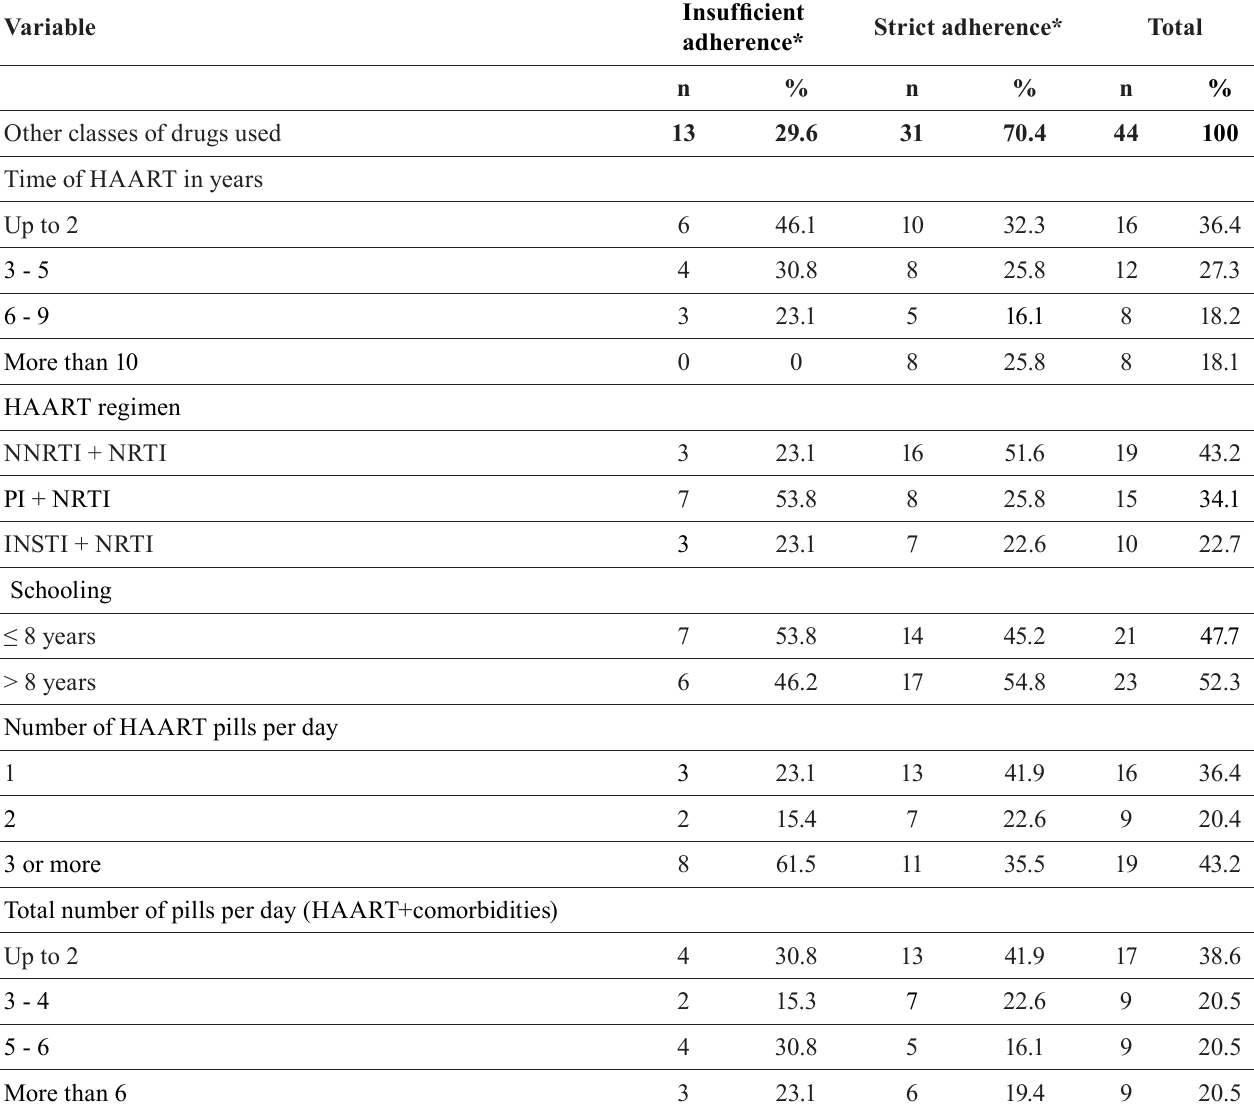
TABLE VI - Patient-related characteristics, according to CEAT-HIV adherence Variable